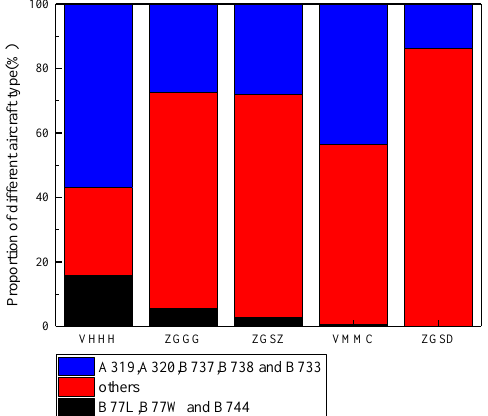
ff erent airports in the GBA in